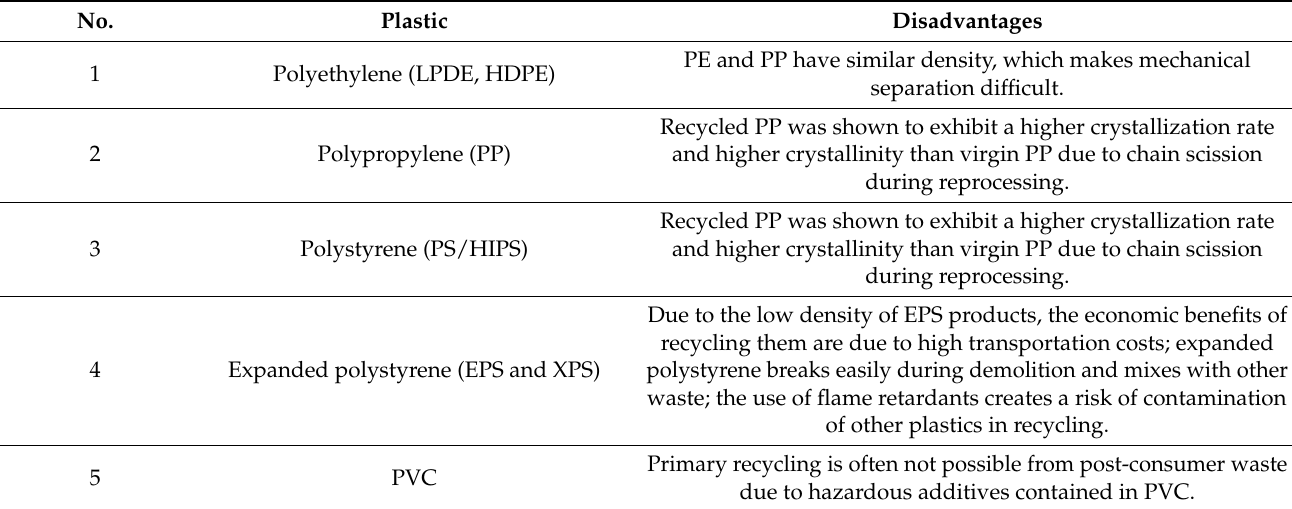
Table 1. Possible disadvantages of using recycled plastics